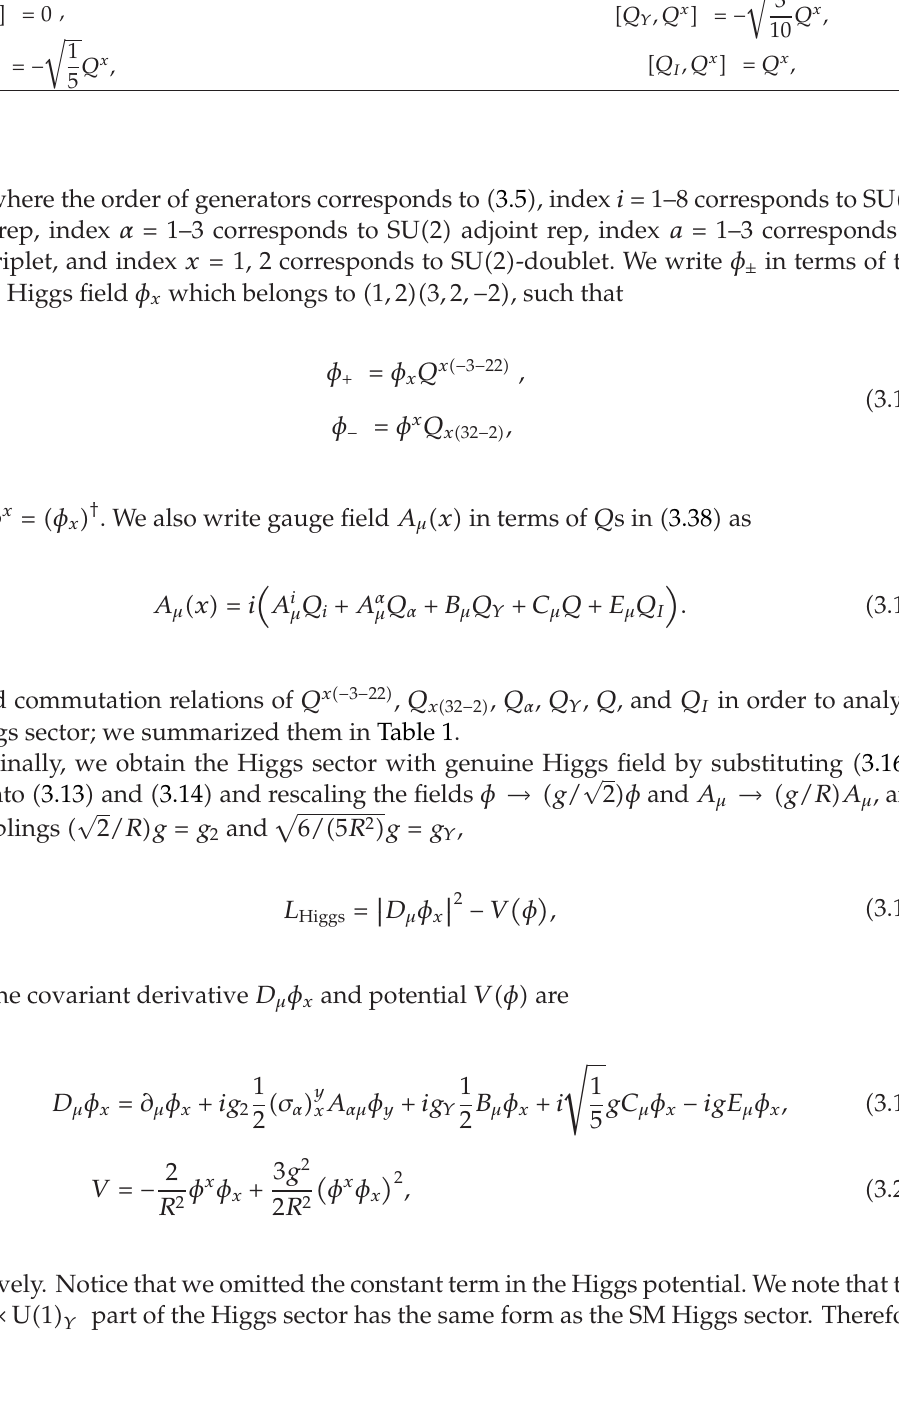
Table 1: Commutation relations of Q x (cid:2) − 3 − 22 (cid:3) , Q (cid:4) Q x (cid:2) − 3 − 22 (cid:3) ,Q (cid:5) (cid:6) y (cid:2) 32 − 2 (cid:3)